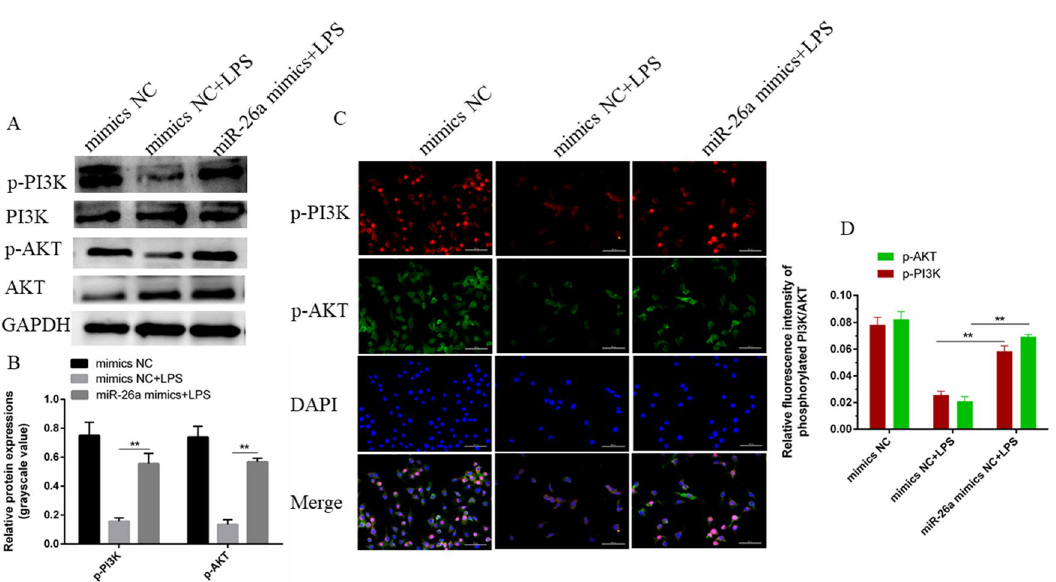
Figure 6. Overexpression of miR-26a activates PI3K/AKT signaling. ( A ) Western blot experiments indicated that the overexpression of miR-26a reversed the LPS-mediated expression down-regulation of p-PI3K and p-AKT. ( B ) The protein gray value was calculated by IPP6.0 software. GAPDH is set to the control internal reference. ( C ) Immunofluorescence suggested that ( A ) the same conclusion, and the overexpression of miR- 26a can activate the PI3K/AKT axis (× 400, scale bar = 50 µm). ( D ) IPP6.0 calculated IOD/area to indicate the fluorescence intensity of PI3K and AKT phosphorylated proteins. p-PI3K shown in red fluorescence, p-AKT is green fluorescence, and the nucleus is blue; Merge (× 400, scale bar = 50 µm). Data are expressed as mean ± S.D., Three independent experiments. ** p < 0.01. The cropping of your gels and blots in the figure legends where